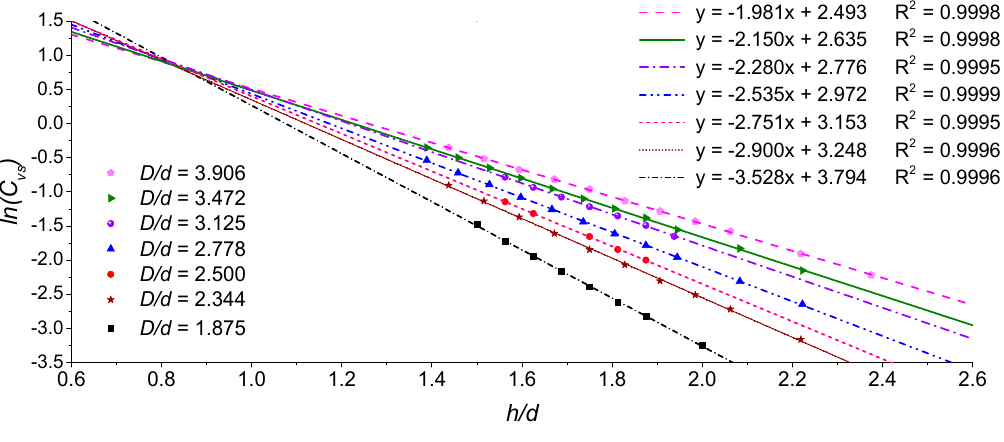
Figure 11. Relations between ln( C vs ) and h / d.